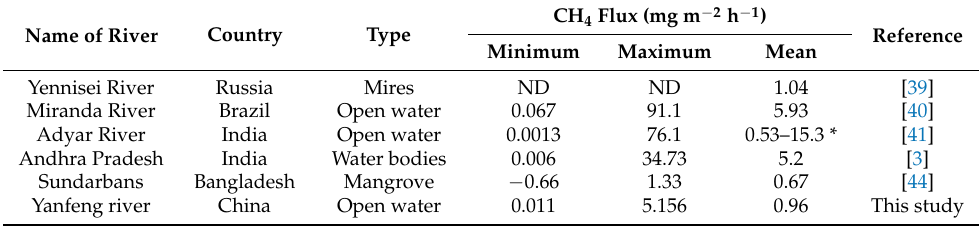
Table 3. Comparison of CH 4 flux of rivers in other regions globally. Name of